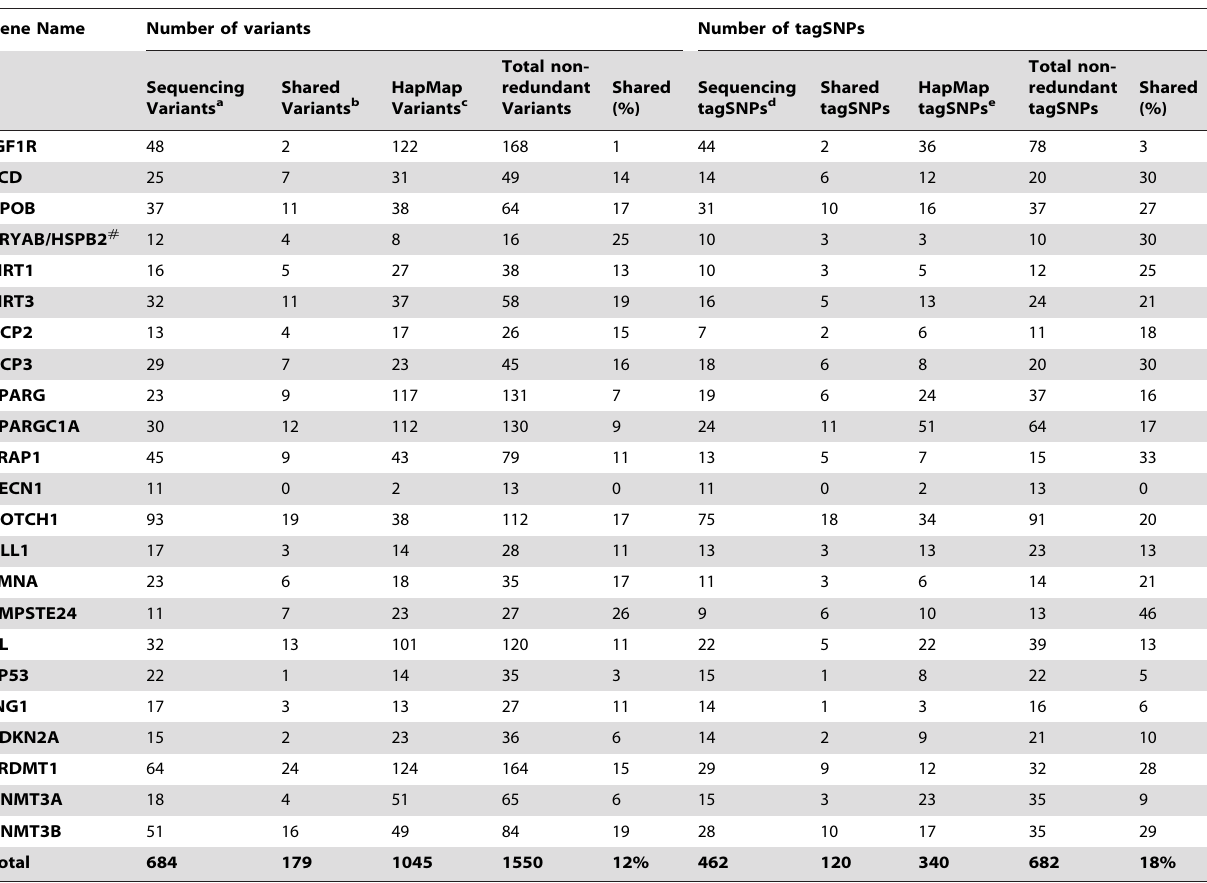
Table 4. tagSNP selection; HapMap versus candidate gene